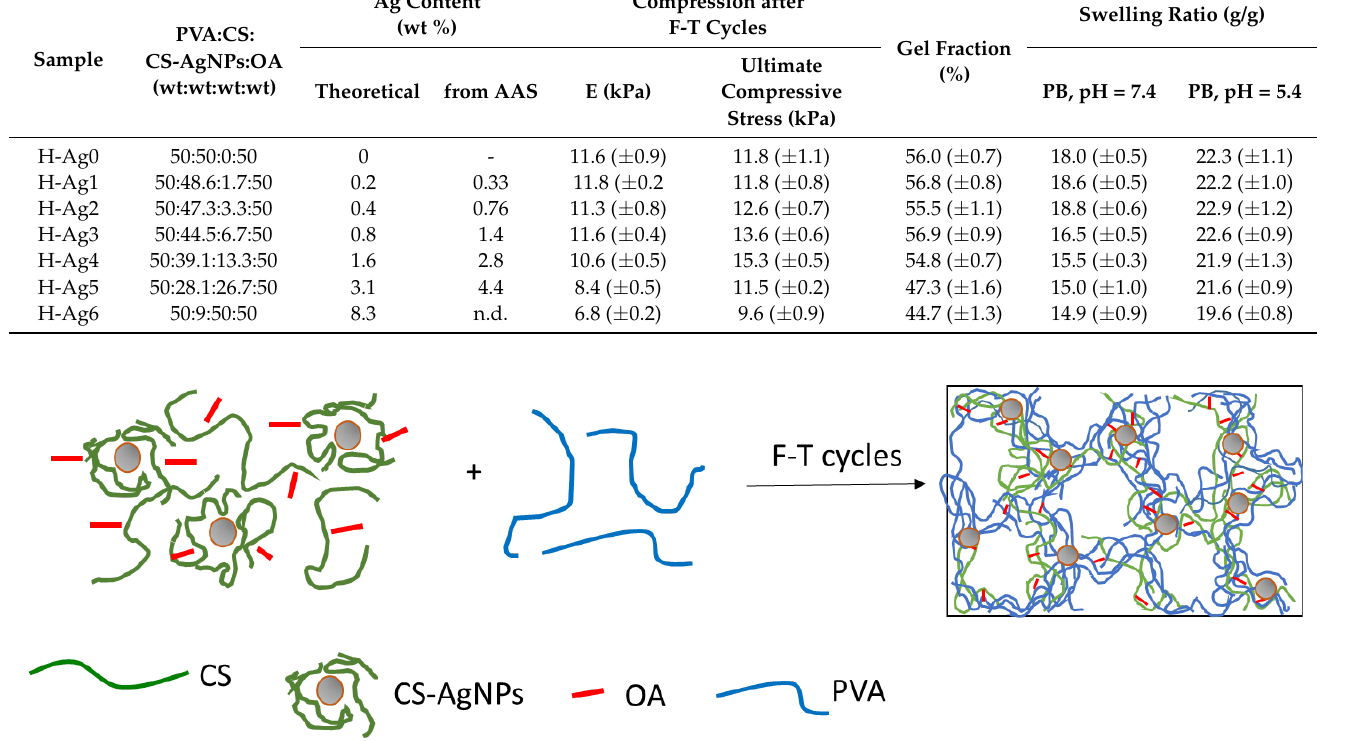
Figure 5. Schematic representation of the preparation of composite hydrogels with embedded AgNPs.